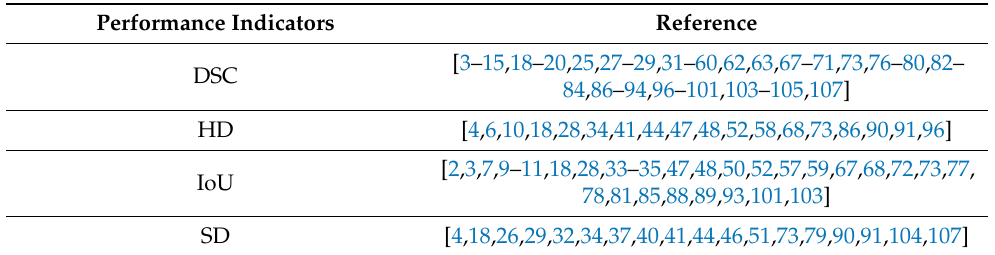
Table 6. Performance indicators most frequently used for the segmentation of musculoskeletal